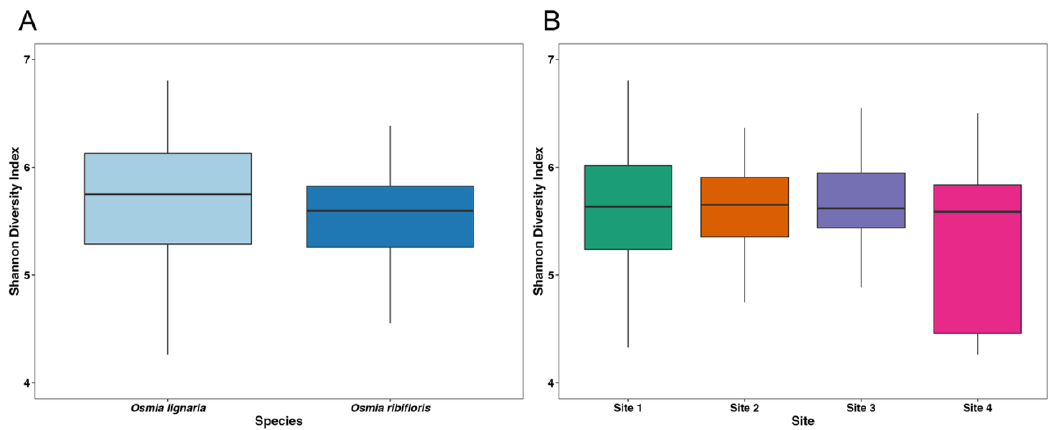
Figure 1. Boxplots of alpha diversity in ( A ) Osmia species, and ( B ) sampling site as measured by the Shannon Diversity Index. Alpha diversity was not significantly di ff erent between Osmia species (H = 1.76, p = 0.18) or sampling site overall (H = 1.42, p = 0.70) and pairwise between sites ( p adj > 0.05 for each comparison).